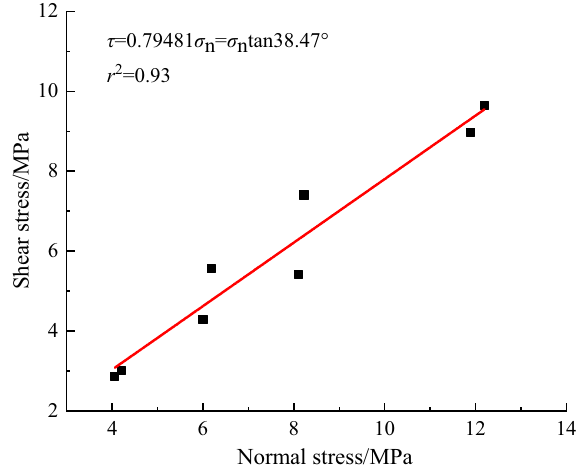
Figure 12. Fitting curve of the shear strengths of the tested ACC-reinforced jointed rock